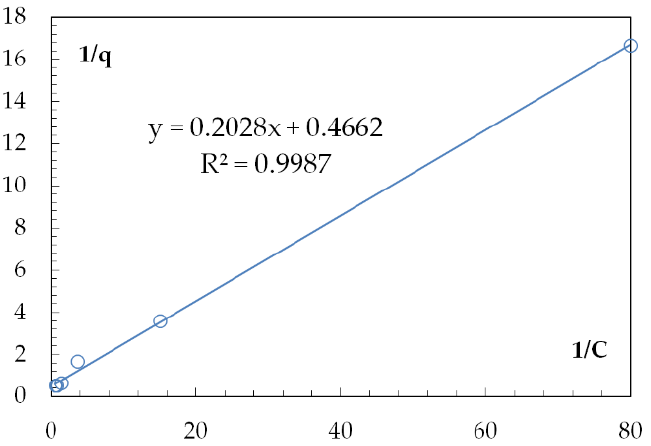
Figure 13. Linear form of the sorption isotherm of acetone on organic material.